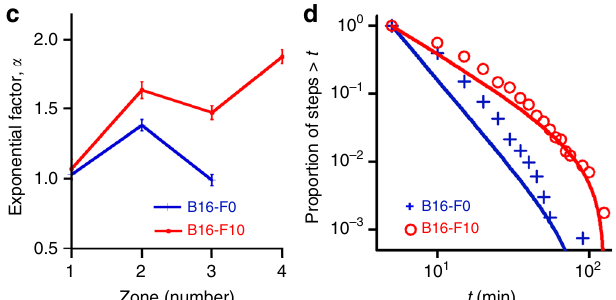
Fig. 4 Migration of non-metastatic and metastatic cells from live tumors in mouse skin. a , b Cell movements within invasion strands formed by up to 100 tumor cells and relation to the guidance structures of the tumor microenvironment, observed by using high-resolution multiphoton microscopy (see Supplementary Movies 7 and 8 for trajectories). The snapshots from these movies are shown for ( a ) B16-F0 and ( b ) B16-F10 tumors. AlexaFluor 750-labeled dextran was used to visualize blood vessels (red), Histone-2B/mCherry marks the nuclei of cells ( green ), and fi brillar collagen was revealed by SHG (second-harmonic generation; blue). Dashed yellow lines divide the invasion strands into fi ve zones, each 150- μ m wide. Scale bar is 150 μ m. c The values of the “ diffusion exponents ” α indicate that both B16-F0 and B16-F10 cells are diffusive at the tumor margin (zone 1, α ~ 1) and superdiffusive (zone 2, α ~ 1.4 – 1.6) with entering the invasion zone. Away from the tumor (zones 3 – 4), however, the metastatic cells remain superdiffusive while the non-metastatic ones show diffusive behavior. Error bars correspond to 95% con fi dence intervals. d The cumulative frequency distributions, CFDs, of persistence times are truncated power law with μ > 3 for diffusive B16-F0 (blue crosses, Zones 1 – 3) and truncated power law with μ ~2.36 for B16-F10 (red circles, Zones 2 – 4) performing Lévy walks. Markers are experimental statistics for persistence times. Solid lines are truncated power law fi ts. Statistical analysis of cancer cell movements in vivo is shown in Table